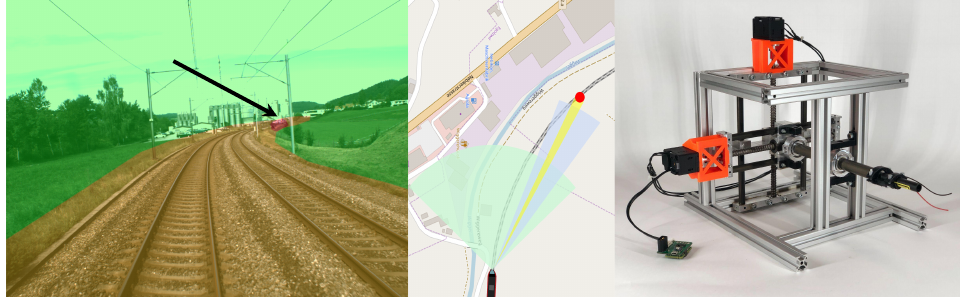
Figure 2. Long-Range Obstacle Detection systems need to focus their sensors on targeted Regions of Interest, shown in yellow and red (arrow), in the vicinity of the railway track. The change of attitude of individual sensors is shown in the centre image, to focus the sensors on possible obstacles. This can be done using a high precision pointing mechanism as shown on the